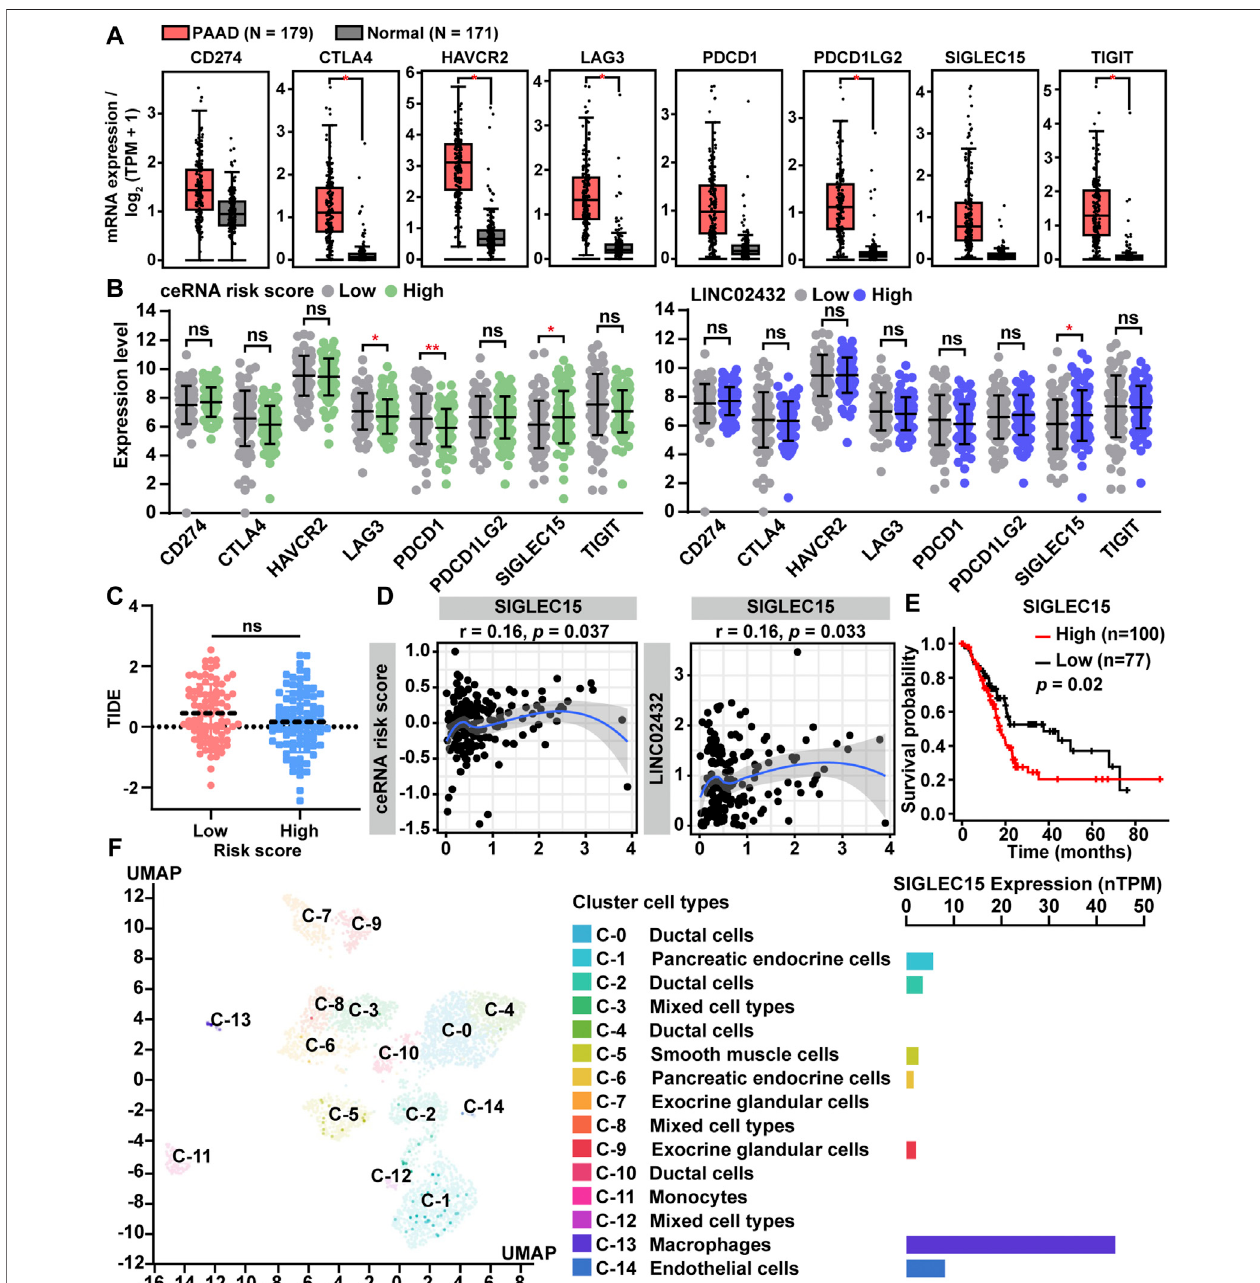
FIGURE 7 | Correlation of ceRNA risk score with the expression of immune checkpoint genes for PAAD. (A) The expression of eight immune checkpoint genes betweenPAADtissuesandnormalpancreastissues. (B) Theexpressiondifferencesofeightimmunecheckpointgenesamongdifferentgroups. (C) Statisticalanalysisof TIDE scoresbetweenlow and high riskgroups. (D) The correlation between SIGLEC15 expression and ceRNA riskscorewasanalyzed by Pearson correlation analysis. (E) Theprognosticsigni fi canceofSIGLEC15assessedbyKaplan-Meieranalysis. (F) SIGLEC15expressionwasidenti fi edindifferenthumanpancreascelltypesby scRNA-seq data from the